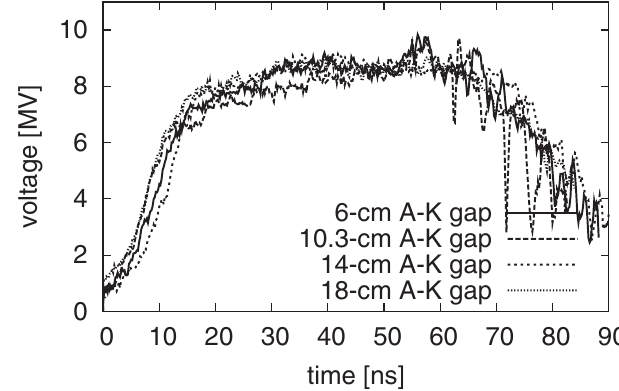
FIG. 9. Voltages at diagnostic position E calculated from mea- sured currents for large-area-diode loads with A-K gaps of 6, 10.3, 14, and 18.1 cm for the dustbin/knob configuration (RITS-6 shots 63, 58, 67, and 5, respectively).